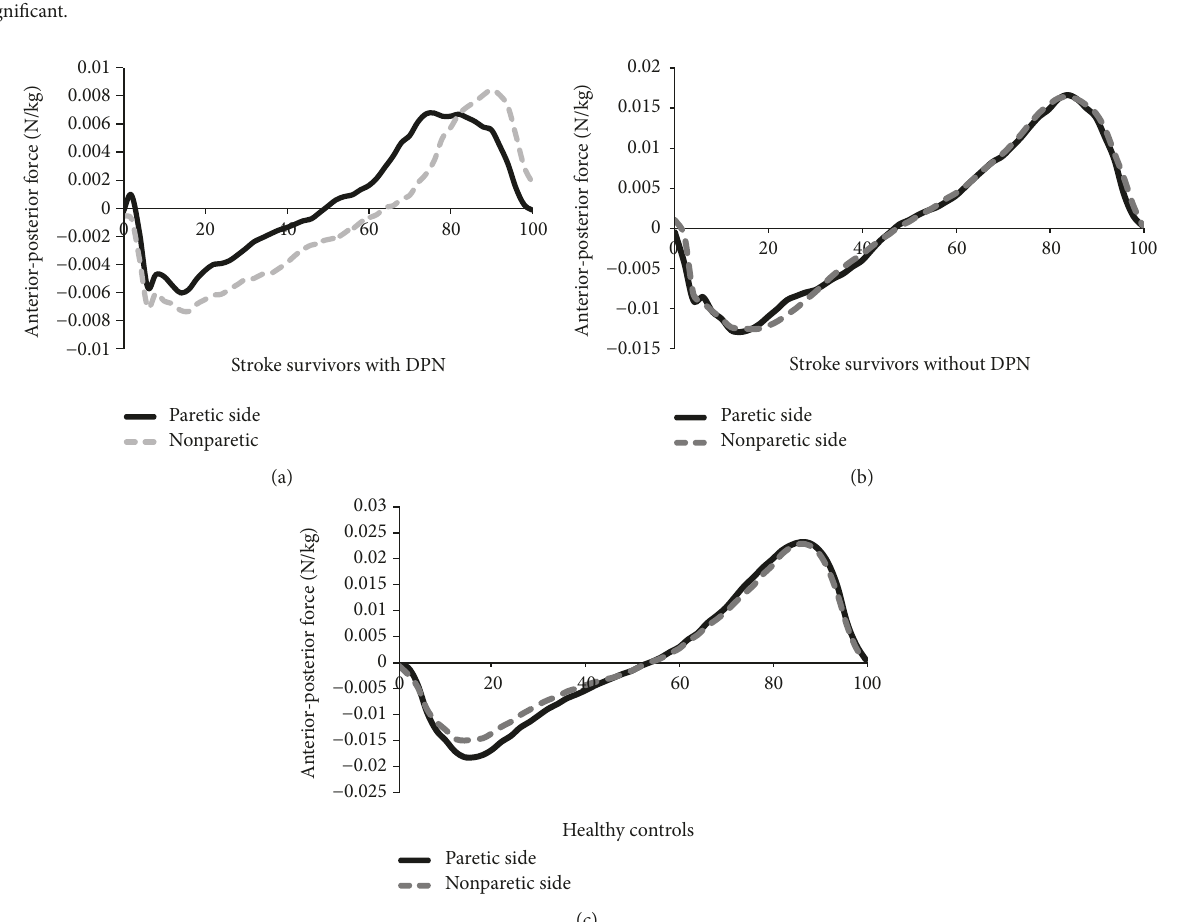
Figure 1: (a) Anterior-posterior forces of the paretic and nonparetic side of stroke survivors with DPN. (b) Anterior-posterior forces of the paretic and nonparetic side of stroke survivors without DPN. (c) Anterior-posterior forces of the paretic and nonparetic side of healthy controls. DPN: diabetic peripheral